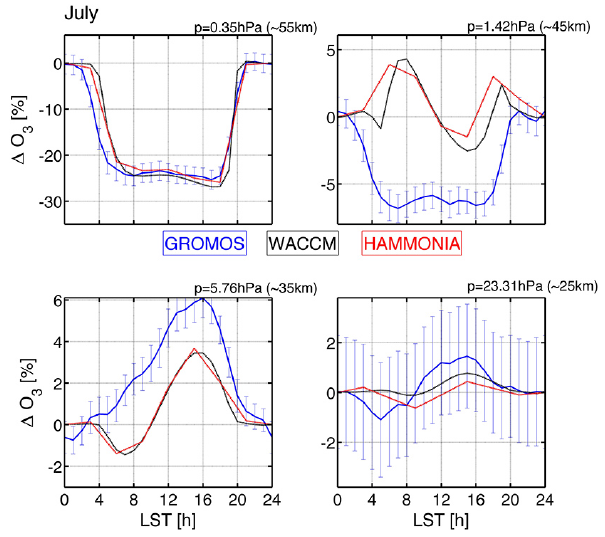
Figure 6b. Same as Fig. 6a but for the month of